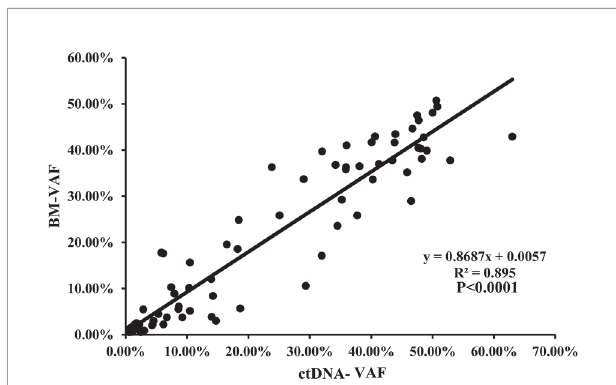
FIGURE 7 | The correlation of the VAFs in the same mutation site detected in BM and PBMC among the 155 individual mutations detected by both assays.